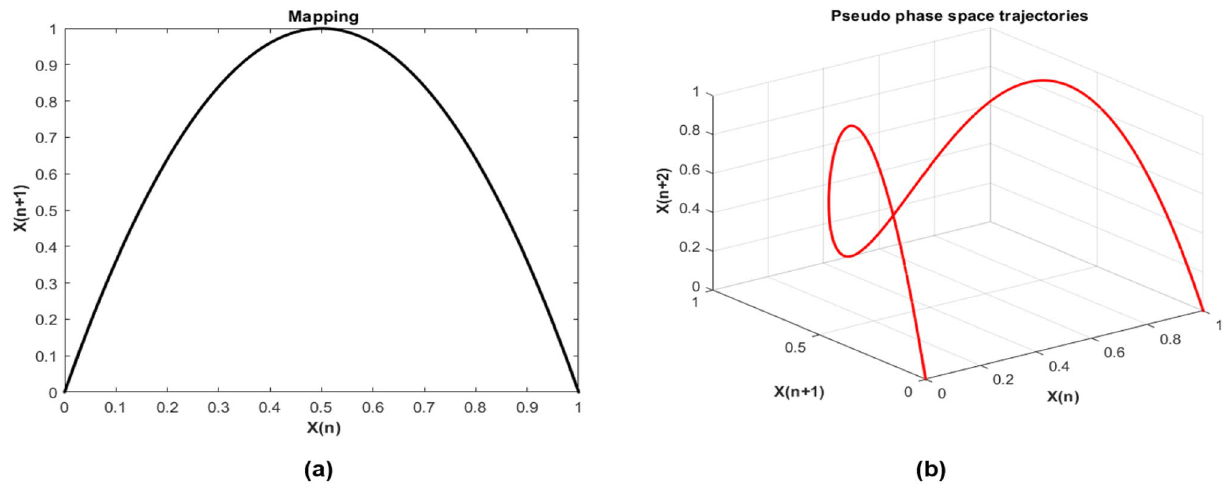
Fig. 2 Shows the a mapping and b pseudo phase space trajectory for the second order symmetric chaotic map, also known as logistic map